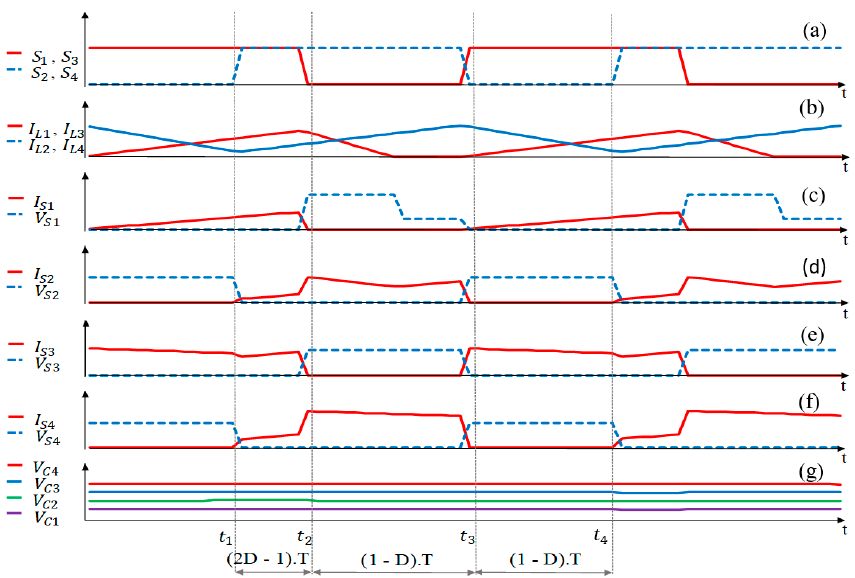
Figure 4. The waveform of the gate voltages ( a ), the voltage and current on switches ( c – f ), inductors ( b ), and capacitors ( g ).